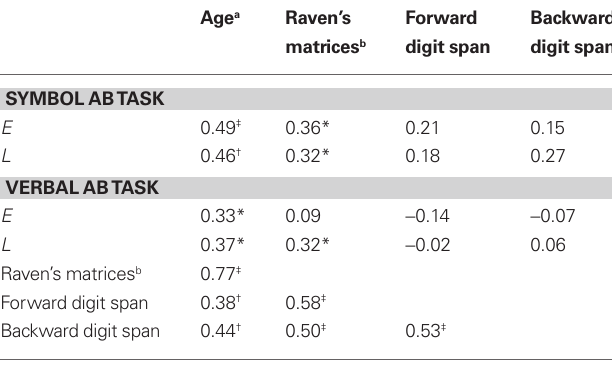
Table 1 | Pearson product–moment correlations ( r ) of age, difference measures E and L inherent in the AB profile, and psychometric assessment variables in the study sample ( n =